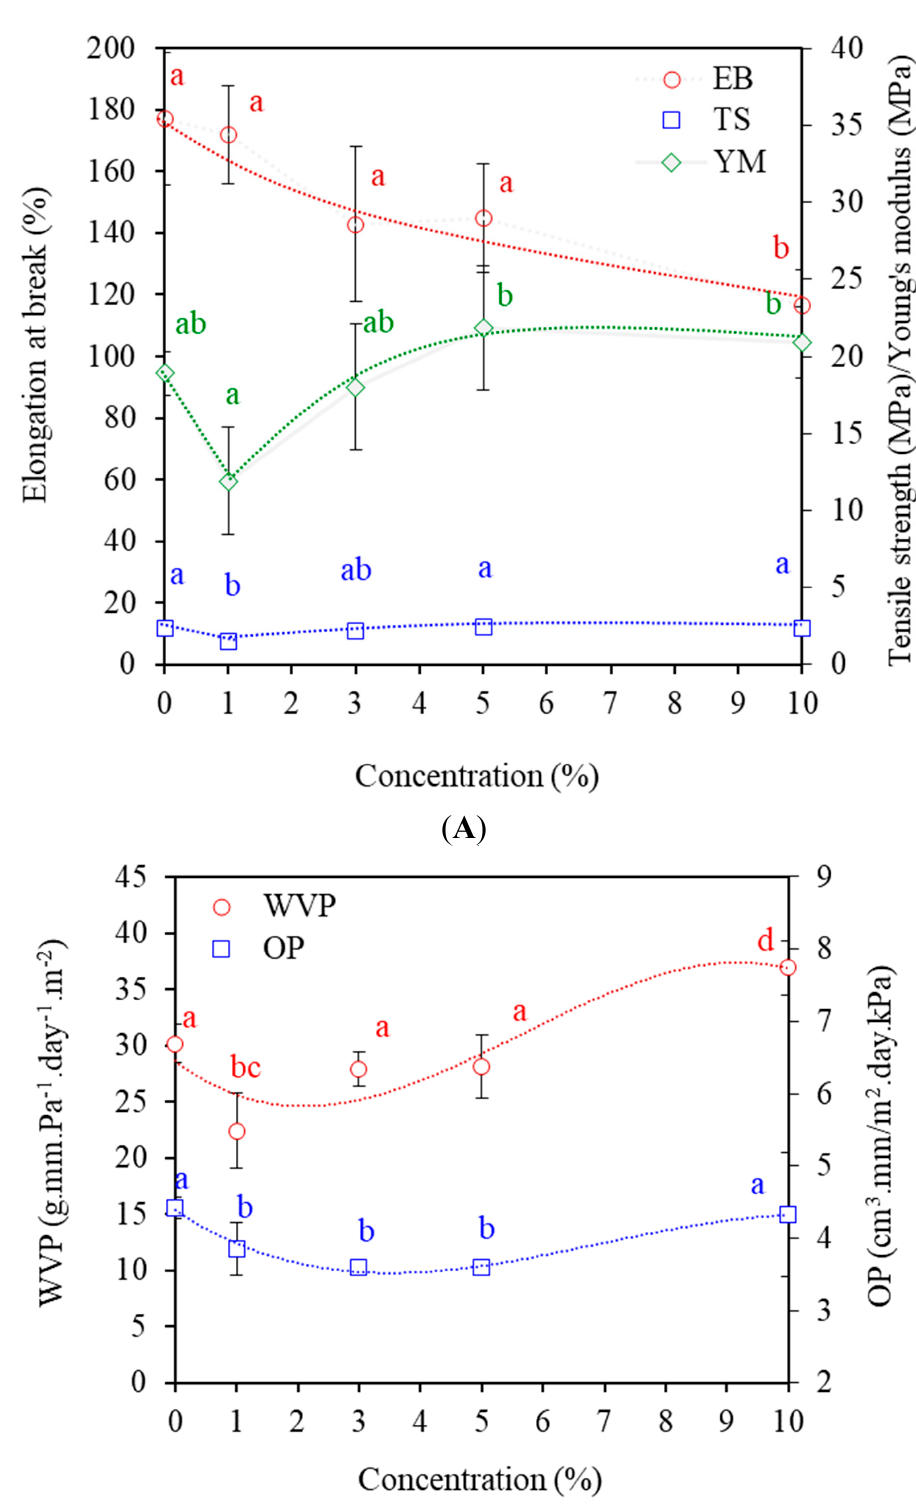
Figure 5. ( A ) Tensile properties as tensile strength (TS), elongation at break (EB) and Young’s modulus (YM) and ( B ) barrier properties as water vapor permeability (WVP) and oxygen permeability (OP) of starch films containing maltol (MAL) at 0, 1, 3, 5 and 10%. Different letters (a, b and c) indicate significant difference ( p ≤ 0.05) between maltol concentrations.